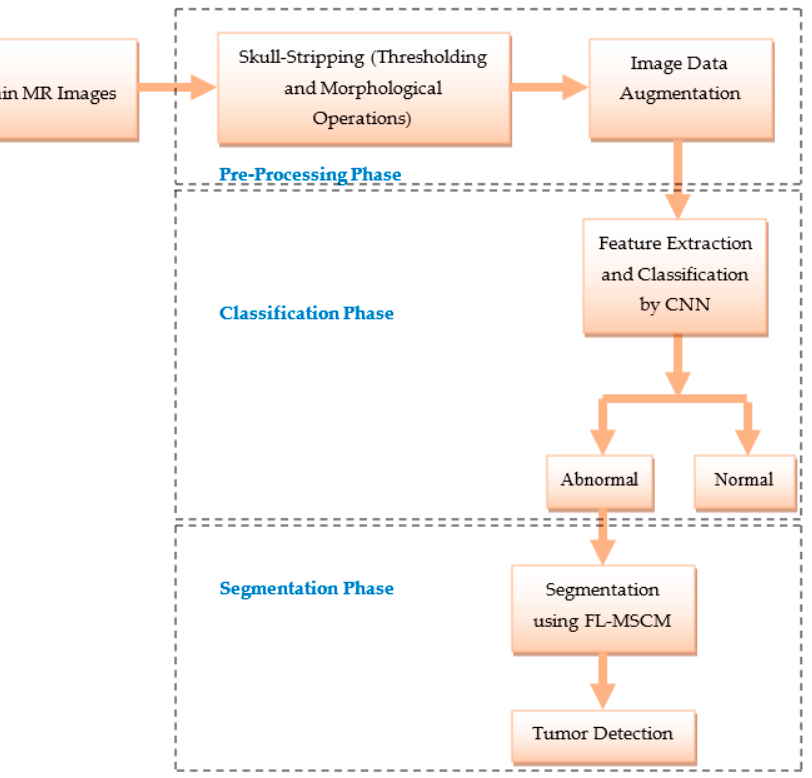
Figure 4. Flow diagram of the suggested brain tumor segmentation and classification